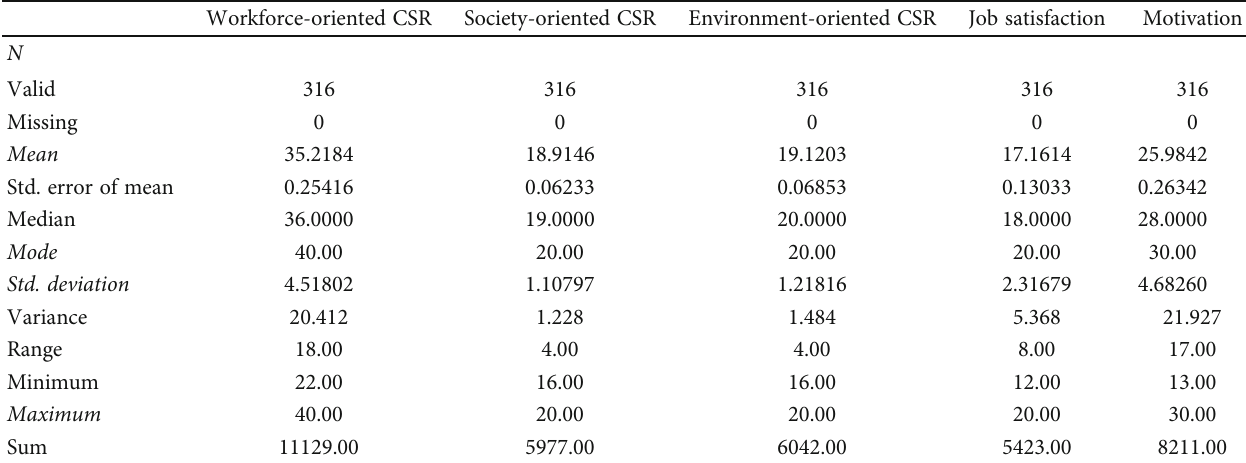
Table 14: Combined descriptive